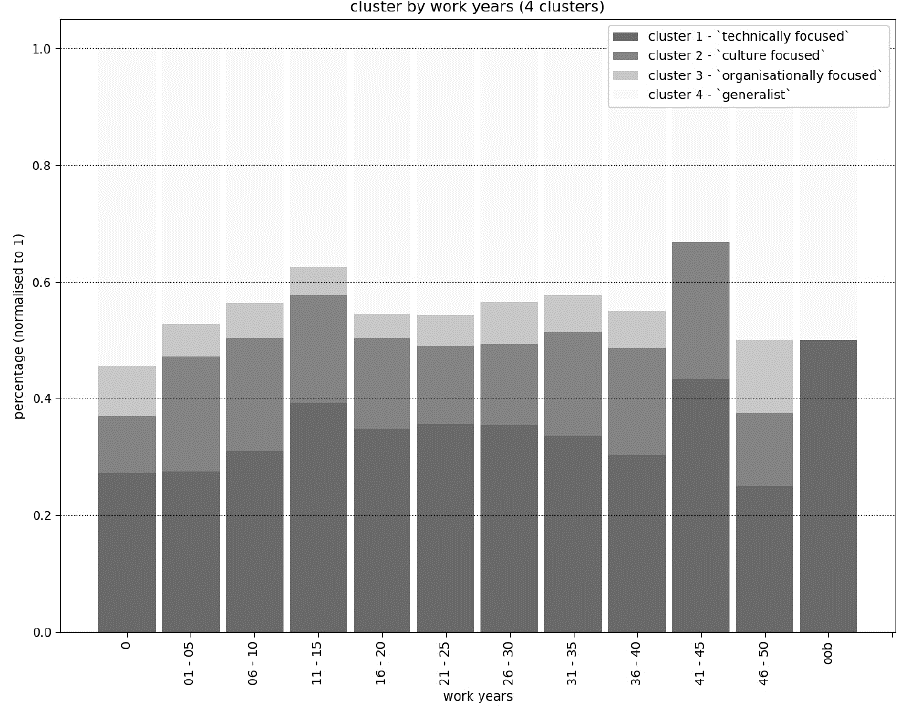
Figure 7. Distribution of work year for each